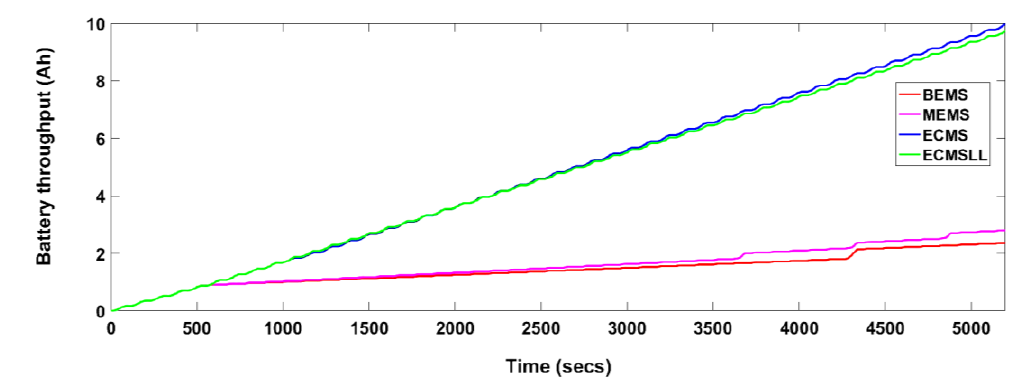
Figure 11. Battery throughput profile for the IDC test cycle. Table 7. Absolute battery throughput and battery throughput rise in percentage for different vehicle configurations tested for WMTC (W) and IDC (I) test cycles. Battery throughput in Ah Battery throughput rise in % Controllers Veh 1 Veh 2